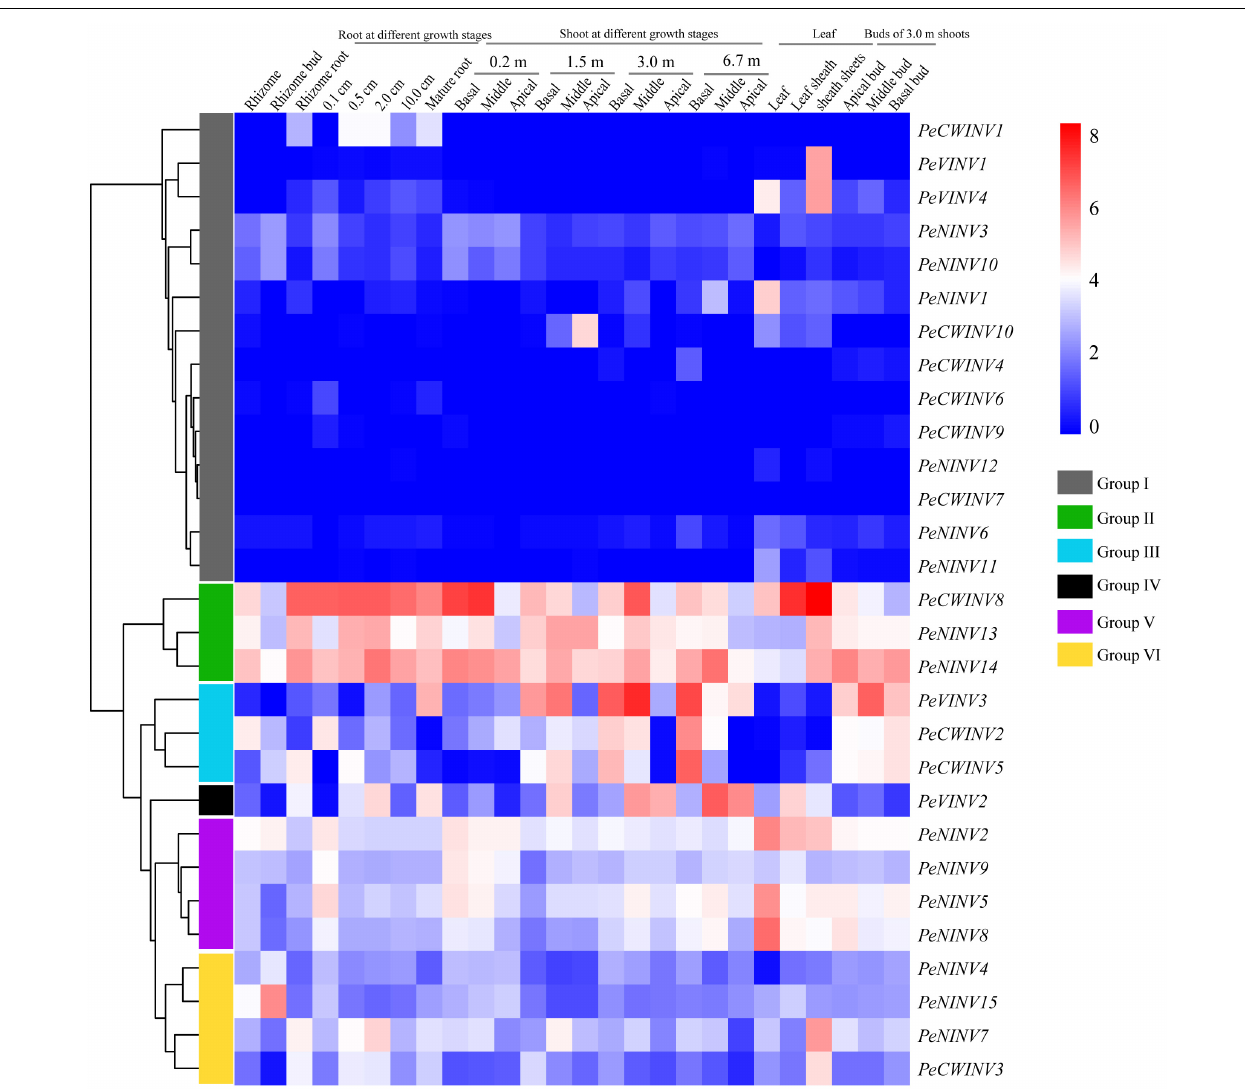
moso bamboo leaves under drought treatment (20% PEG-6000) were further validated by